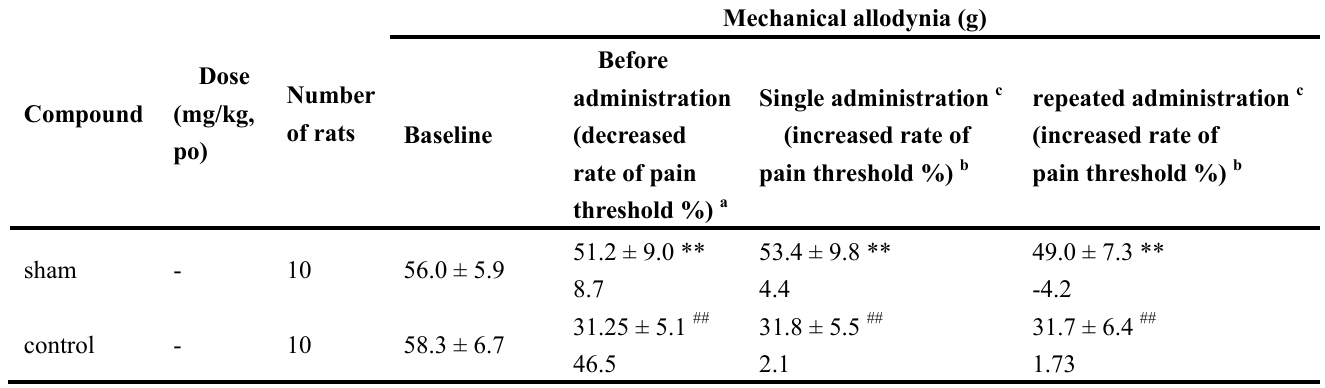
Table 5. Effects of compounds on mechanical allodynia in the CCI model.